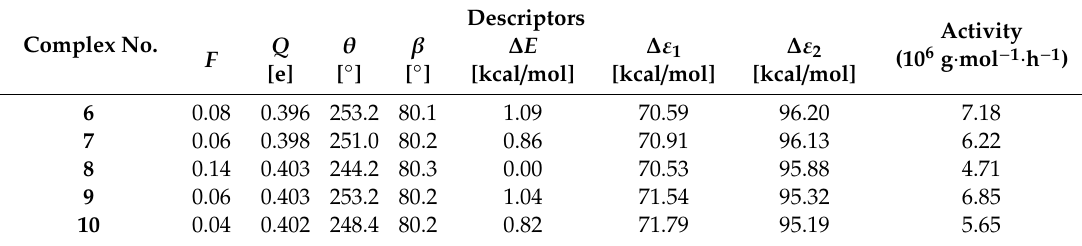
Table 5. The values of Hammett constant ( F ), e ff ective net charge ( Q e ff ), open cone angle ( θ ), bite angle ( β ), energy di ff erence ( ∆ E ) and HOMO–LUMO energy gap ( ∆ ε 1, ∆ ε 2 ) together with experimental catalytic activities for complexes 6 – 10 . Complex